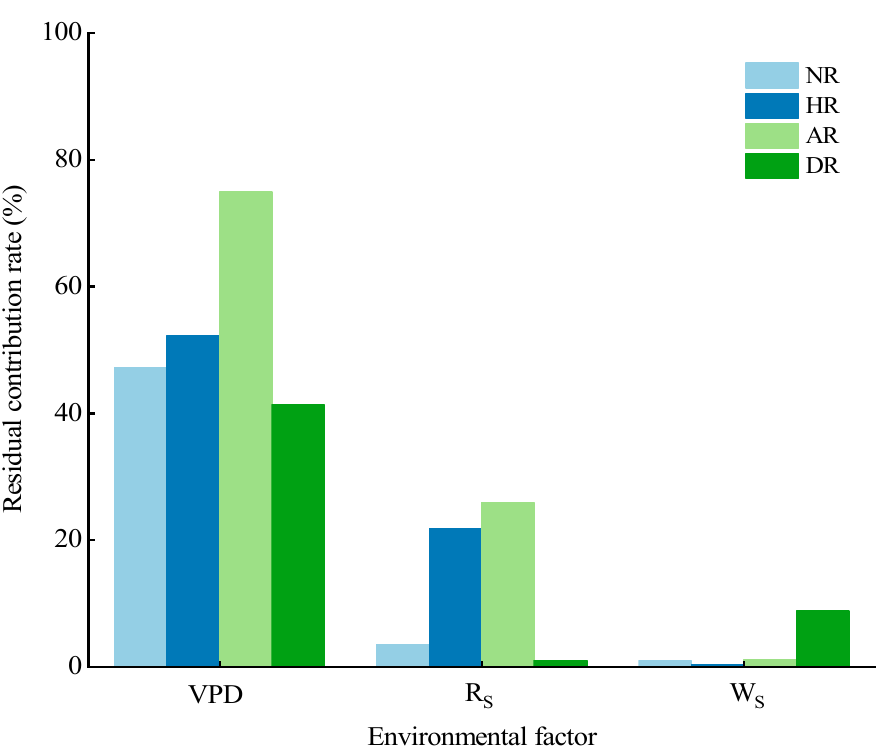
Figure 10. The contribution rate of the residual error between the Q and environmental factors impacting the growth of P. orientalis during the observation period. The contribution rate of four treatments area are NR treatment (NR), HR treatment (HR), AR treatment (AR), and DR treatment (DR). Table 2. Fitted results of daily Q and environmental factors of P. orientalis